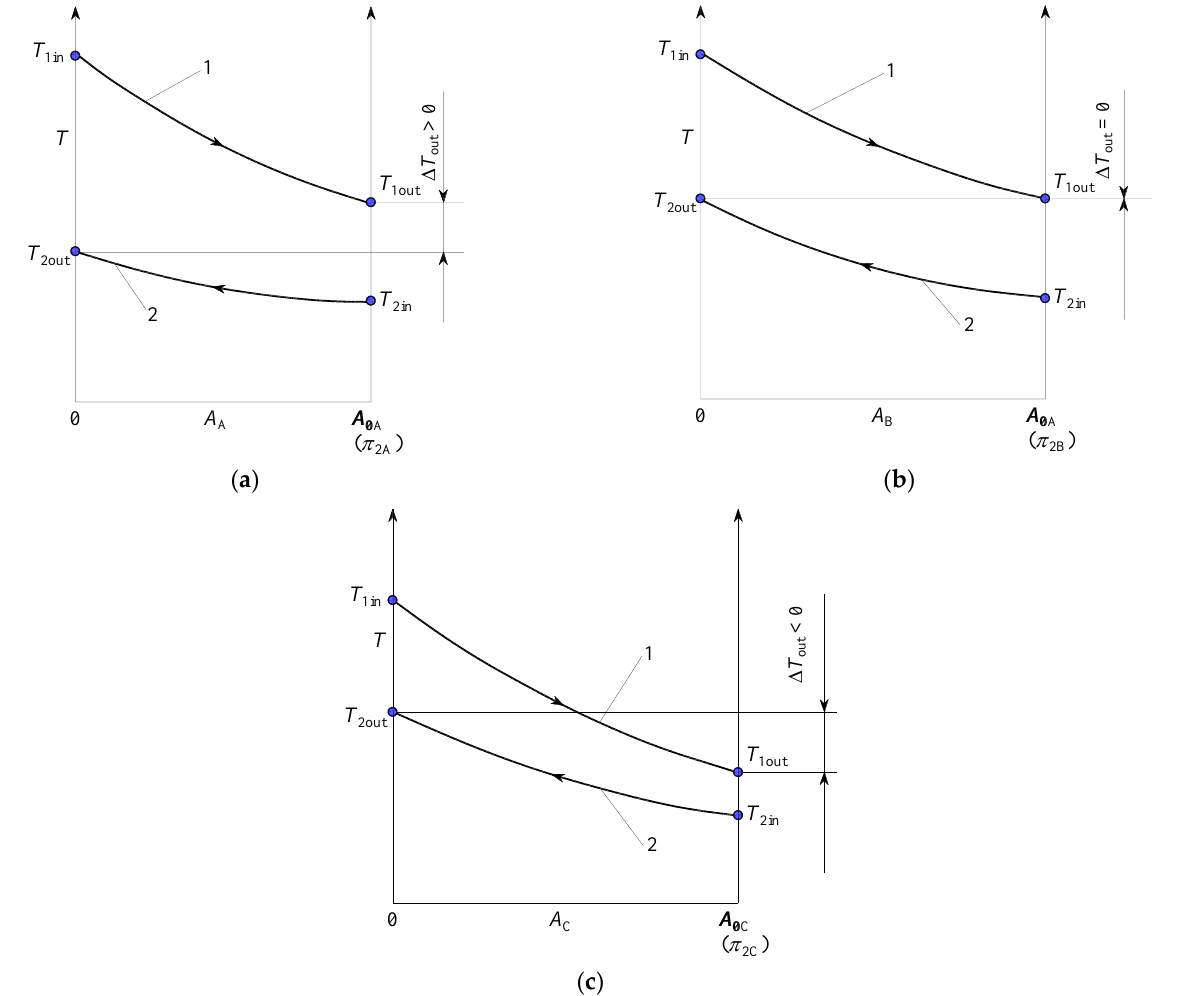
8 of 24 Figure 2. Characteristic π 2 values and temperature streams in the balanced counter-flow recu- perators A, B and C: ( a ) Δ T out > 0. ( b ) Δ T out = 0. ( c ) Δ T out < 0. For a case where π 2A < π 2B = 1.0, temperature distribution is shown qualitatively in Figure 2a, and for a case where π 2C > π 2B = 1.0, temperature distribution is shown in Figure 2c. Completely analogous phenomena also occur in other counter-flow recuperators where π 3  1.0, shown in Figure 3a – c. For π 2 = π 2st , equal outlet stream temperatures are obtained. Such temperatures would be obtained if the inlet streams were mixed in one adiabatic mixing chamber. According to this fact, the energy equation of the adiabatic mixing chamber is given, with a condition: T out = T 1out = T 2out . () 11 i n22 i n12ou t C T